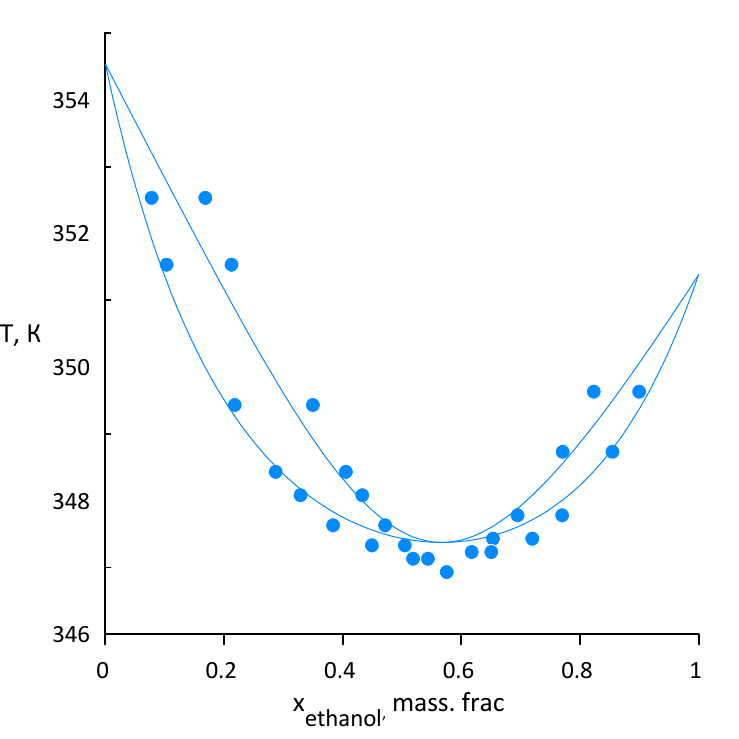
Figure 11. TXY diagram for the binary system ethanol–acetonitrile. The line is calculated using the UNIFAC model (Table 2), the dots are the experimental data from [61].